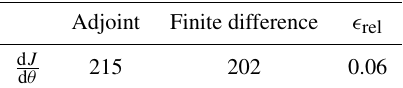
Table 1. Comparison of the wind direction gradients by finite dif- ferences (FD) and via the adjoint